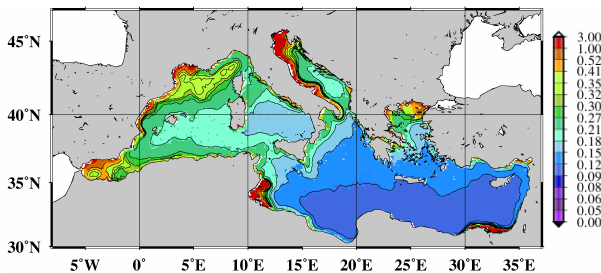
Fig. 5. Spatial distribution of satellite derived chl a as reported by D’Ortenzio and Ribera d’Alcala’ (2009).